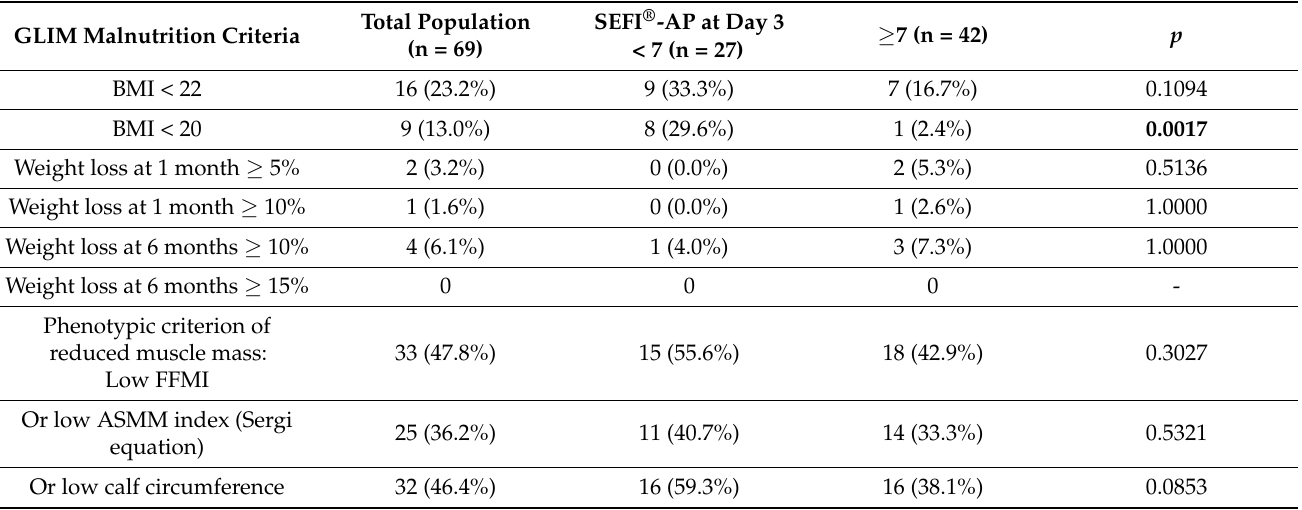
Table 5. Proportion of patients (n = 69) being malnourished according to the Global Leadership Initiative for Malnutrition phenotypic criteria considered, and the Simple Evaluation of Food Intake ® assisted by photography (SEFI ® -AP) at day